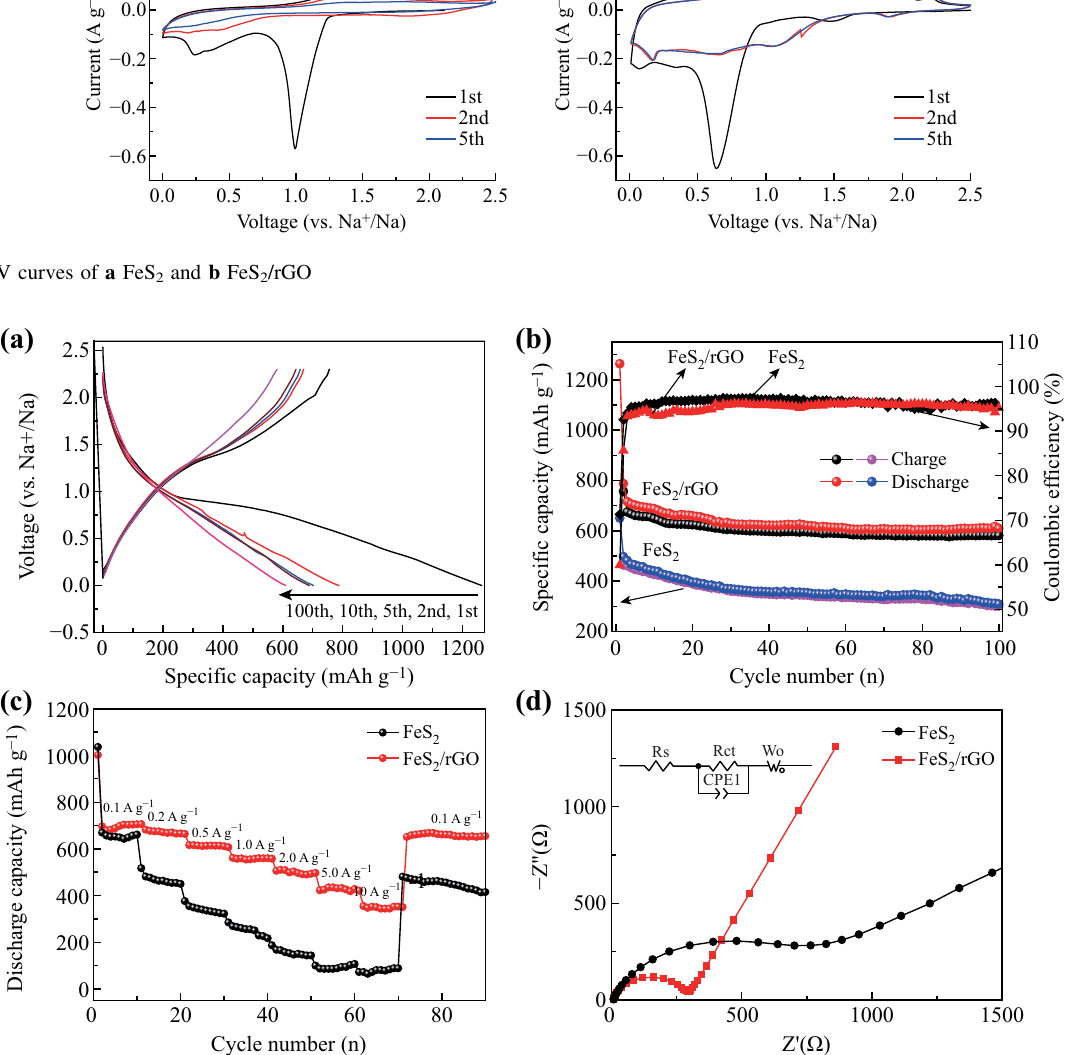
Fig. 5 a Galvanostatic charge–discharge curves of FeS 2 /rGO, b cycle life and coulombic efficiencies, c rate performance, and d Nyquist plots for FeS 2 and FeS 2 /rGO